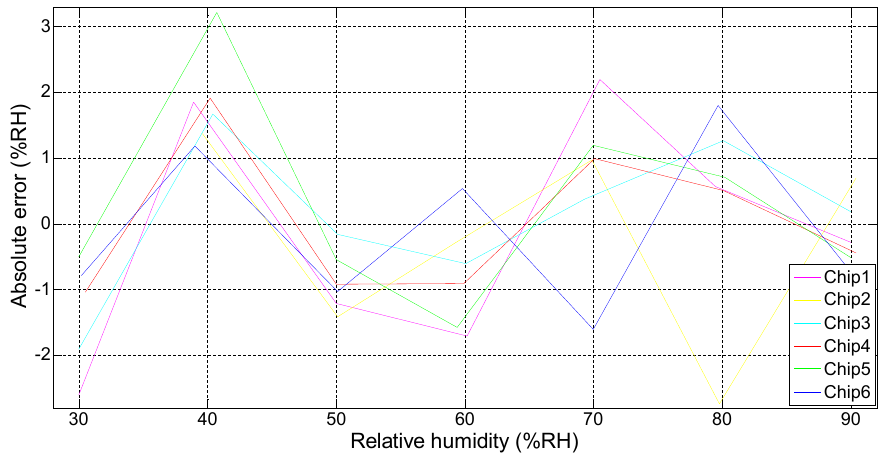
Figure 13. Measured relative humidity error at 25 °C.